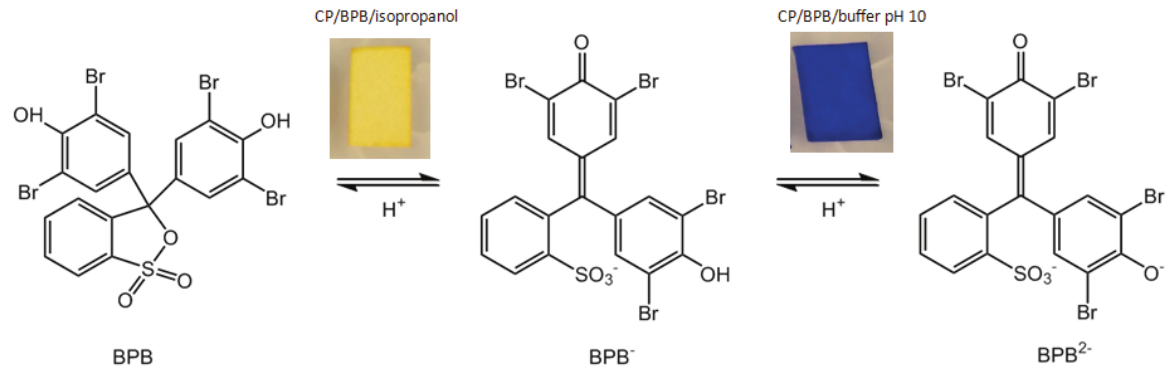
Figure 2: Chemical structures of neutral to negatively charged BPB and images of CP aft er immersion in BPB in: isopropanol (yellow) and a buff er solution at pH 10 (blue).